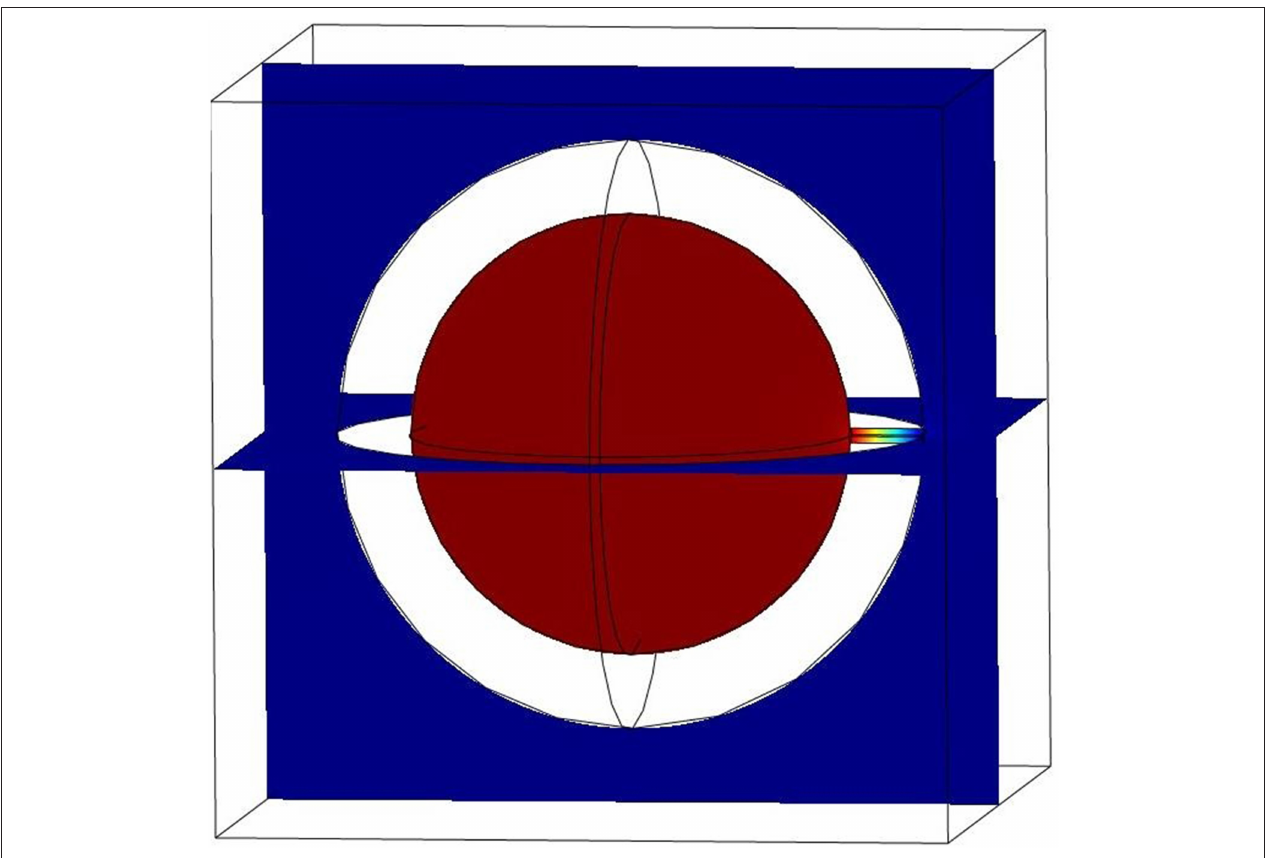
FIGURE 5 | The eigenfunction corresponding to the eigenfrequency ω ∗ 1 51.4250 rad.s − 1 for one thin channel. Blue color corresponds to nearly vanishing amplitude = of the eigenmode u , while red color corresponds to it maximum value. The pressure field p is constant inside the inner cavity and outside the shell, but it varies rapidly inside the thin channel: it is a localized eigenmode responsible for the stop band in Figure 4 , which is well approximated by a spring mass model.